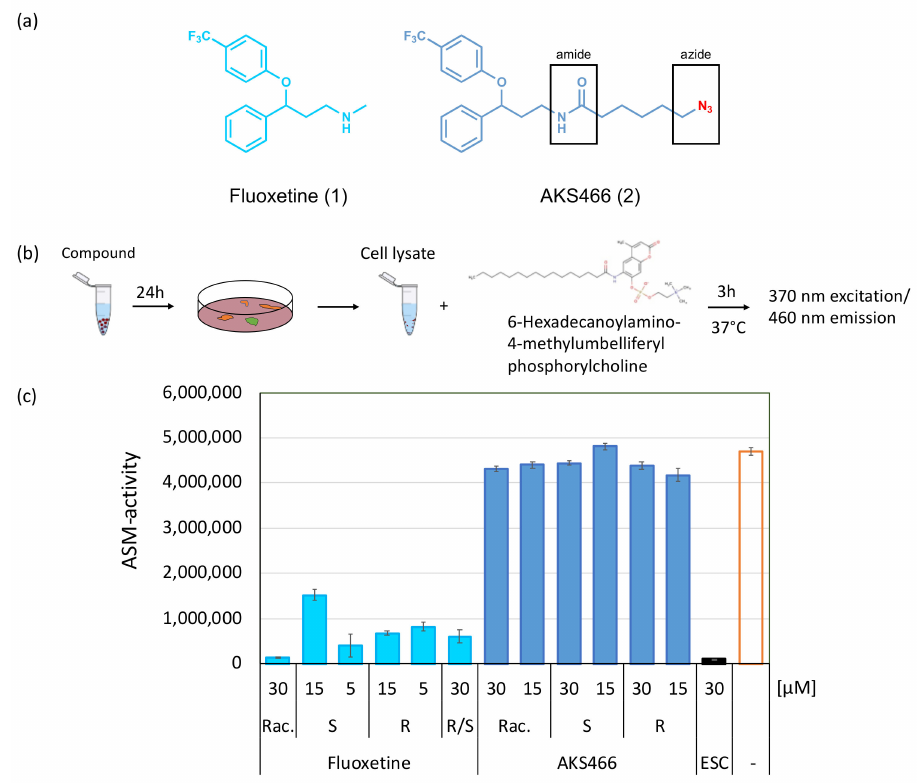
Figure 2. Component AKS466 does not inhibit the ASM activity significantly . ( a ) Molecular structures of fluoxetine and the derivative AKS466. ( b ) Scheme of the ASM assay, and ( c ) ASM assay on Huh-7 cells. The cells were incubated with the compounds for 24 h, lysed, and the HMU-PC substrate was added. The cleavage activity was determined by fluorescence. ESC: escitalopram; Rac: racemate; S and R: stereo-enantiomer; R/S: one to one R/S mixture of